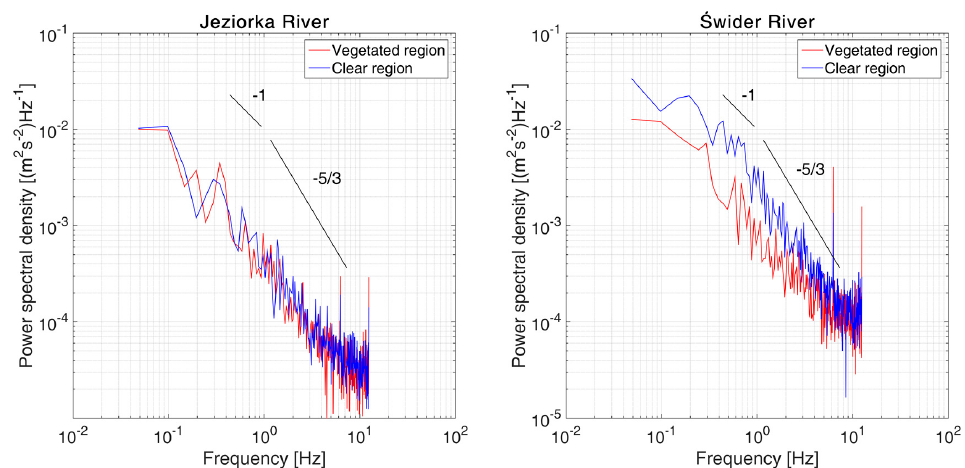
Figure 8. Power spectrum of longitudinal velocities calculated from the filtered signal of long-duration measurements. Table 3. Mean velocity, turbulence intensity, and turbulent kinetic energy of long-time measurements.